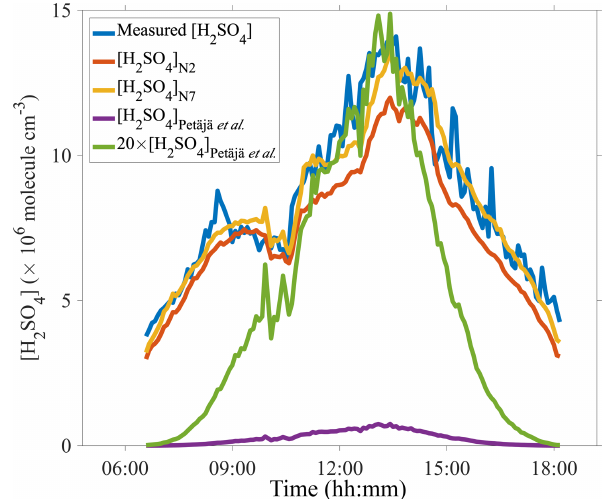
Figure 3. Performance assessments of proxy N2 and proxy N7. The REs are used to evaluate the performances of proxy N2 and N7, respectively, as a function of linear bins of measured sulfuric acid concentrations.